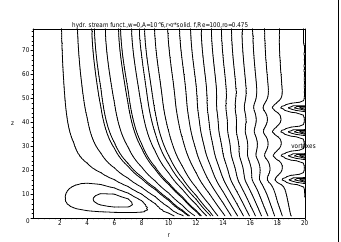
Figure 5. Streamlines of velocity in a pipe with the reduced input, Re = 10 ,A = 2000 .